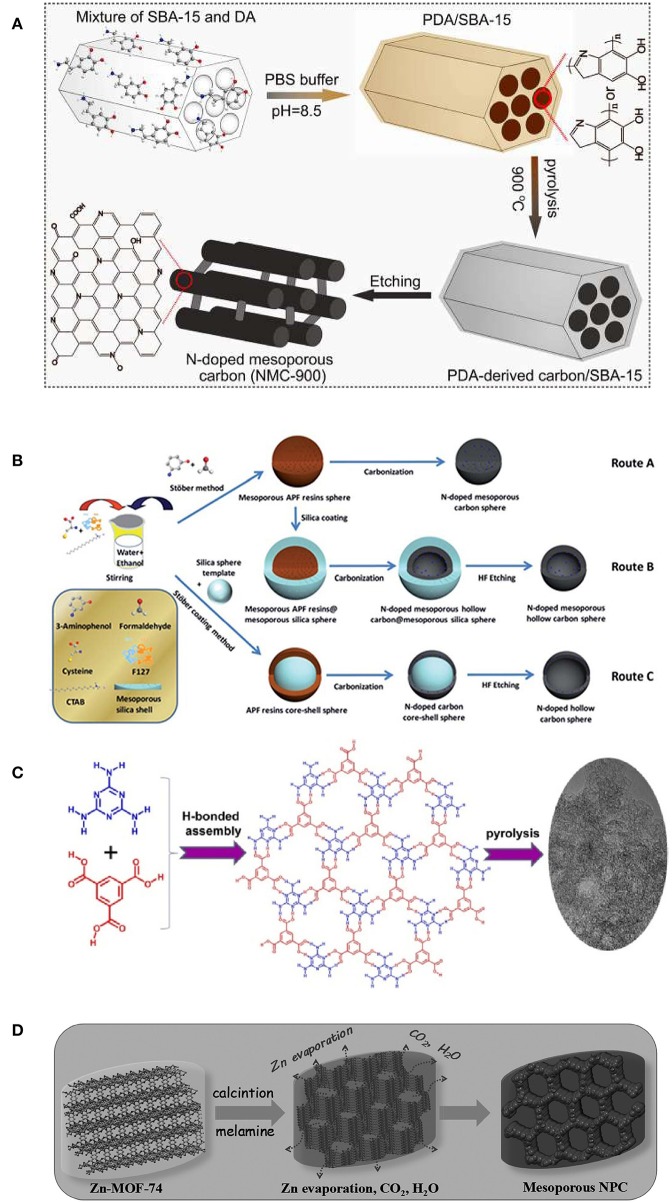
(A) Fabrication of PDA-derived NMC-900. From Qu et al. (2018) with permission from Wiley. (B) Experimental routes were taken to prepare the N-doped carbon spheres in different nanostructures (The blue dots represent the N doping). Route A: nitrogen-doped mesoporous carbon nanospheres (N-MCNSs); route B: nitrogen-doped mesoporous hollow carbon nanospheres (N-MHCNSs); and route C: nitrogen-doped hollow carbon nanospheres (N-HCNSs). From Yang T. et al. (2014) with permission from Royal Society Chemistry. (C) The process of preparation of N-doped mesoporous carbon from HOF. From Liu C. et al. (2016) with permission from Wiley. (D) The process of preparation of the nitrogen-doped mesoporous carbon. From Ye et al. (2017) with permission from Wiley.